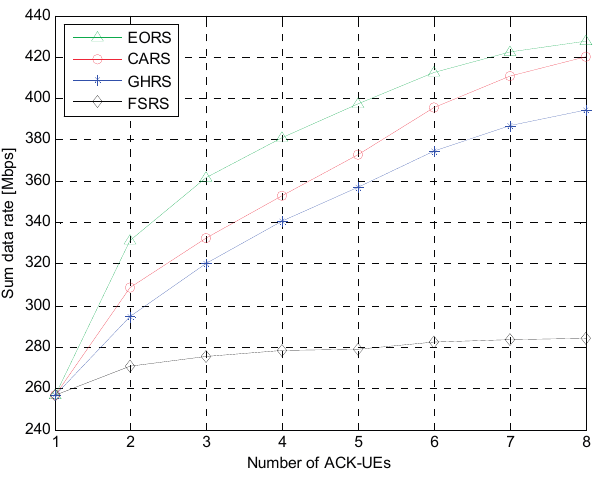
Figure 3. System sum data rate for different relay selection algorithms in the case of 4